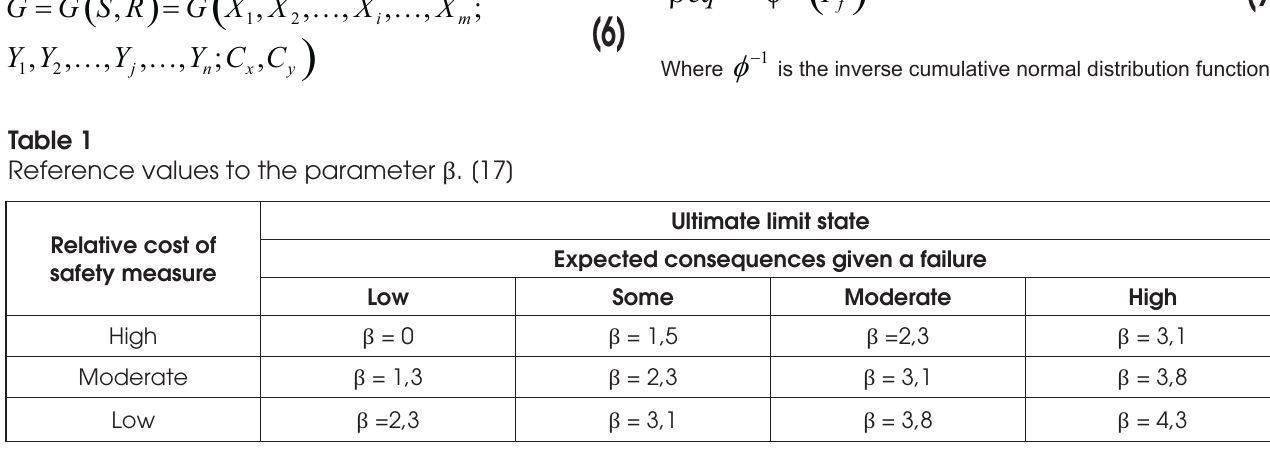
Table 1 Reference values to the parameter